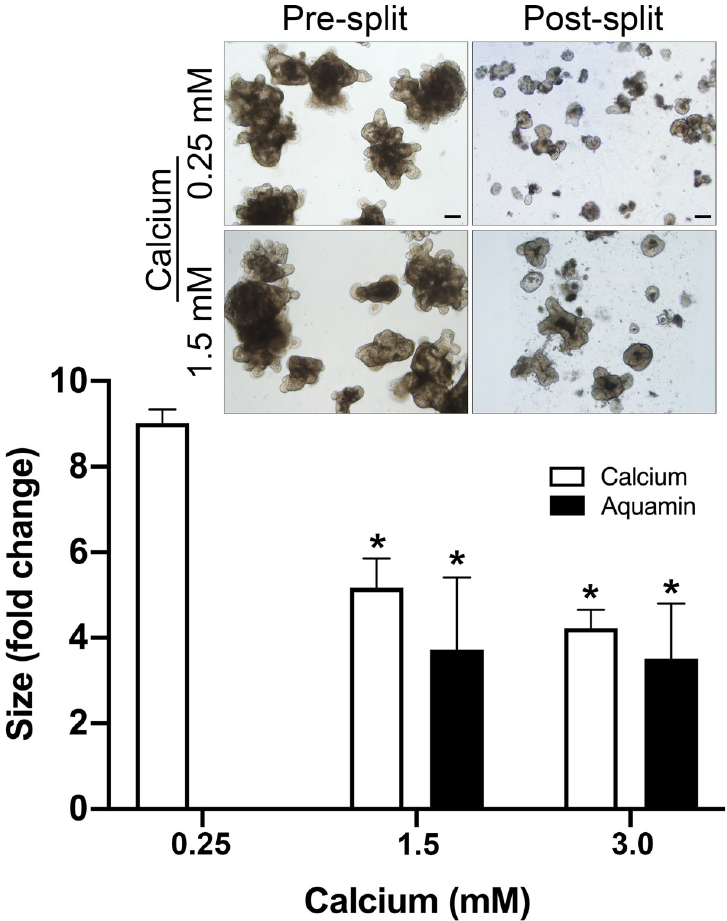
Fig 5. Colonoid cohesion. Colonoids were maintained for 14 days in culture under the indicated conditions. At the end of the incubation period, the size of multiple individual colonoids was assessed by measuring surface area in phase-contrast images. Following this, the colonoids were harvested and fragmented for subculture. After plating, the fragmented colonoids were again “sized.” Values shown represent the change in surface area means and standard deviations of individual colonoids based on three separate experiments representing colonoids from three different subjects with a minimum of 80 colonoids from each subject assessed per treatment group in both pre- and post-split cultures. Data were compared for statistical differences using ANOVA followed by unpaired-group comparisons. � indicates a difference from 0.25 mM calcium at p < 0.05. Inset: Representative examples of pre-split and post-split colonoids. Scale bar = 200 μ